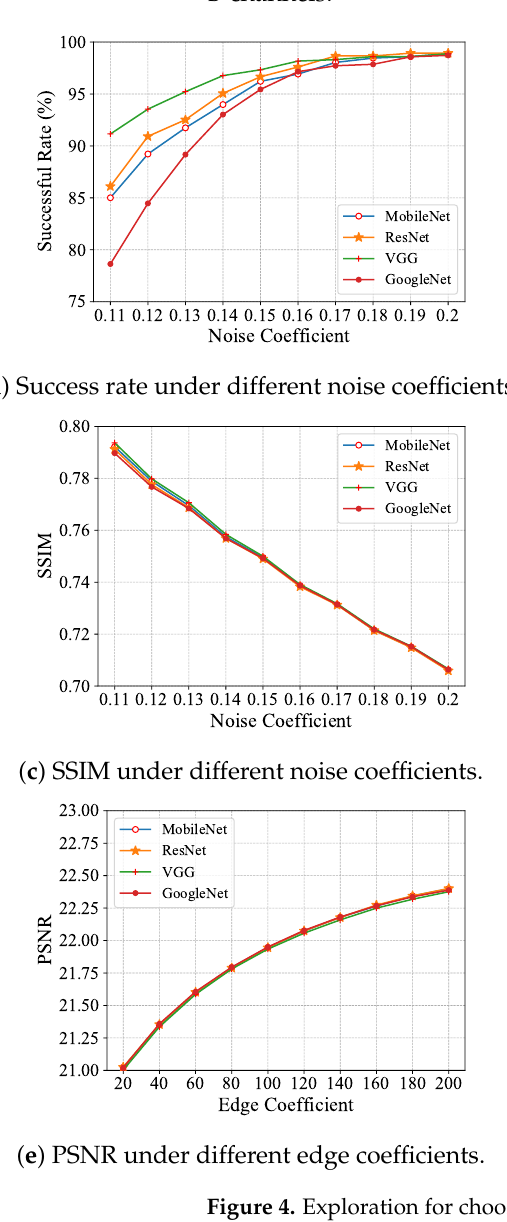
Figure 4. Exploration for choosing noise coefficient and edge